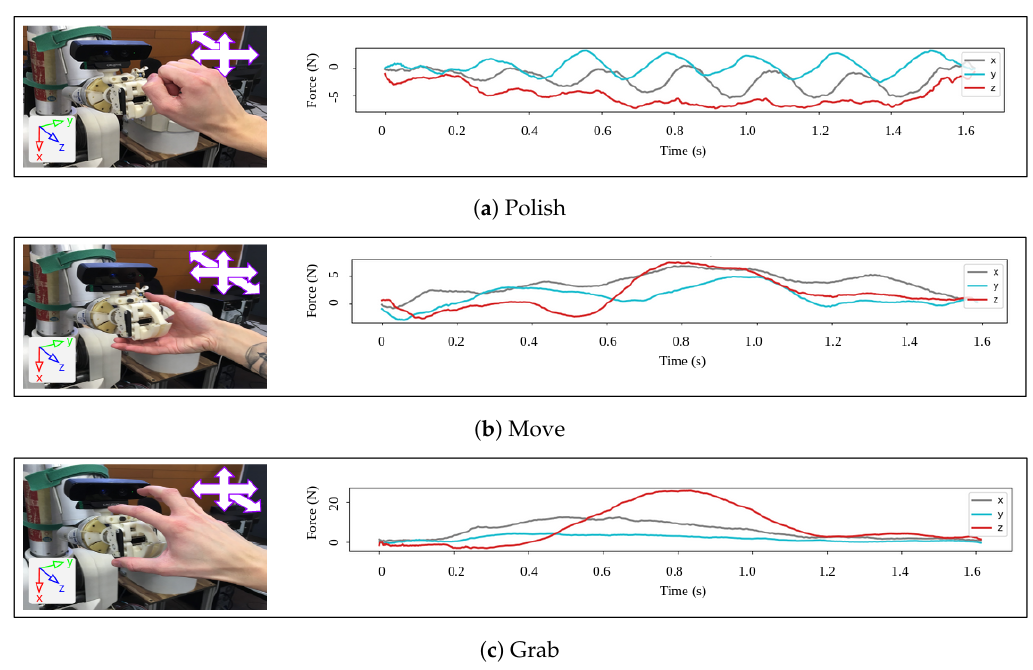
Figure 4. Natural dataset. Human movement patterns (left side) and appearance of the force signals produced by those patterns (right side). Observe how each class ( a – c ) is still similar to the rest even after 0.4 s. Due to the richness in movements, a model trained with this dataset would allow a natural human–robot